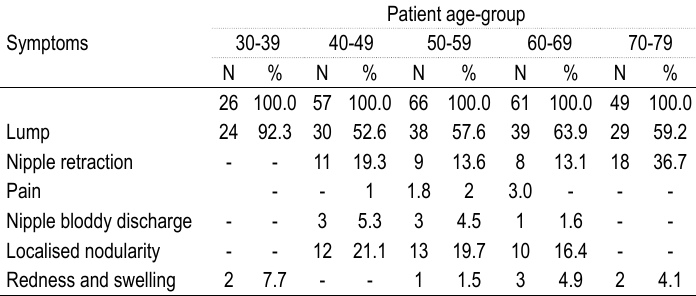
Table 2. breast cancer symptoms according to age